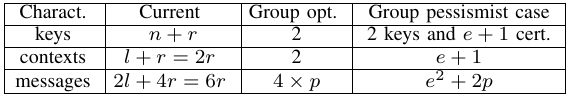
TABLE IV P ERFORMANCES OF THE COMMUNICATION PROCESS